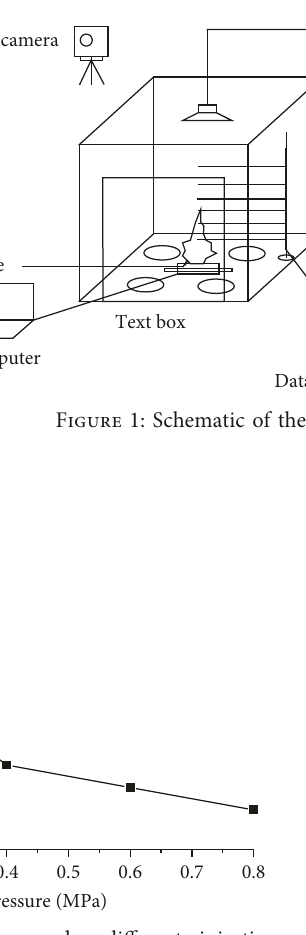
Figure 2: Fire-extinguishing time under different injection pressures.